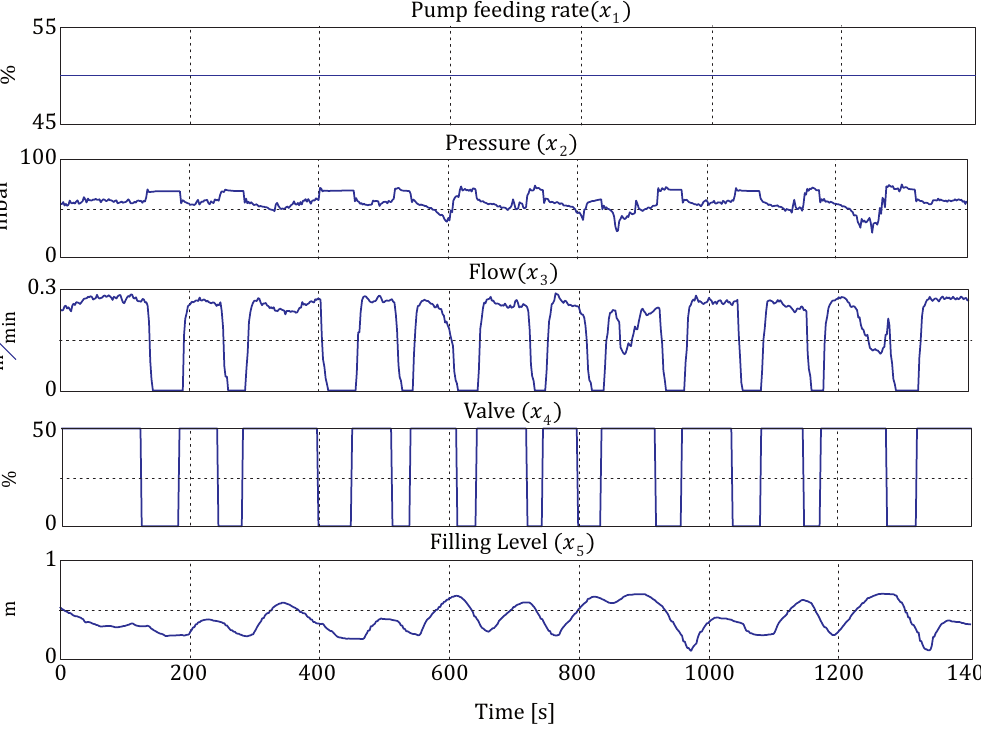
Figure 5. Data of the laboratory plant when having a faulty valve. Sampling rate T